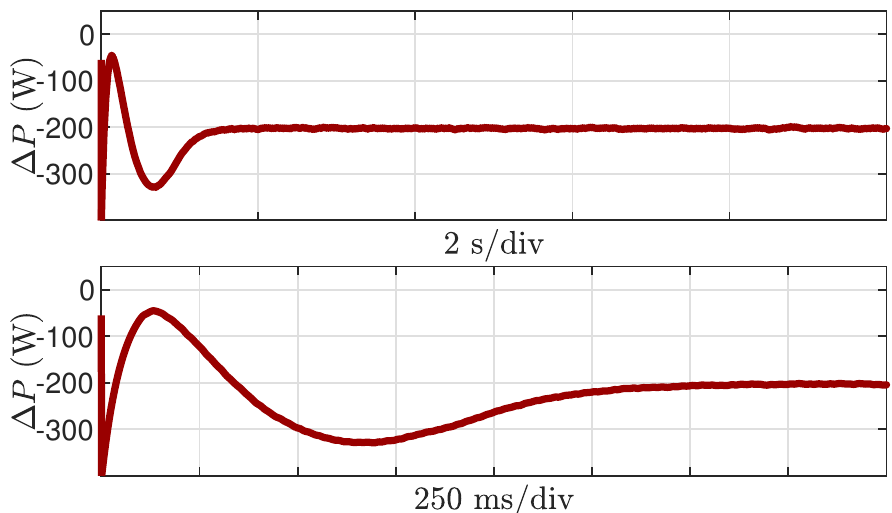
Figure 16. Test Case I: PD–SPWM ∆ P parameter obtained with “virtual V 2